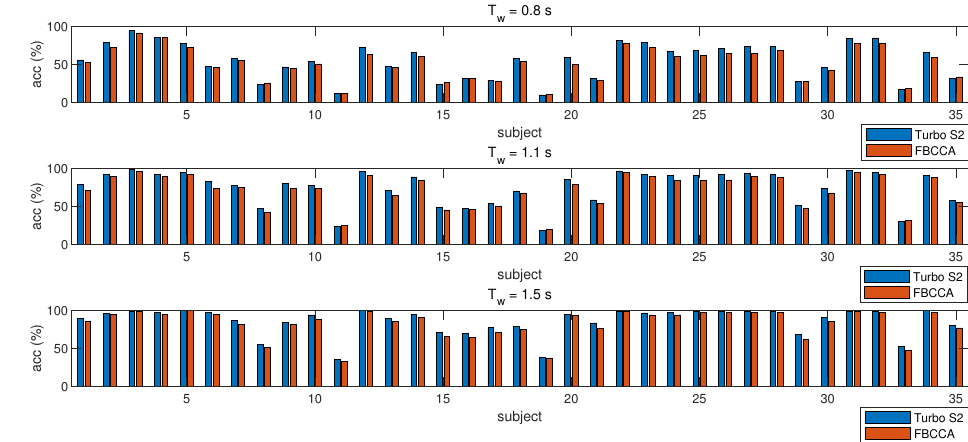
Figure 7. The accuracy of the turbo detector and FBCCA across all the subjects with 0.8 and 1.5 s data